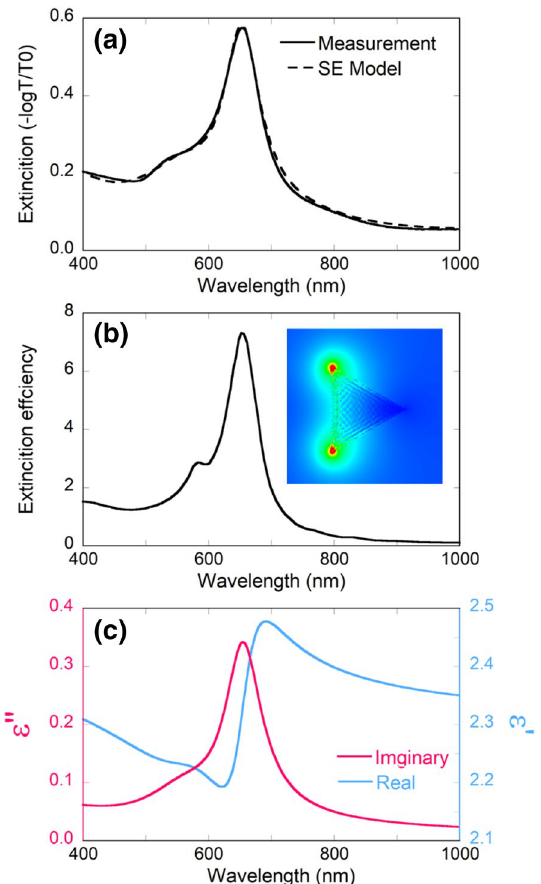
Figure 1. Linear optical properties of Au nanoplates: ( a ) extinction spectrum from ellipsometry measurement and ellipsometric model. ( b ) Extinction ecoefficiency from DDA simulation and corresponding dipole electric filed distribution at 655 nm. ( c ) Real (blue) and imaginary (red) components of dielectric function of nanoplates evaluated by